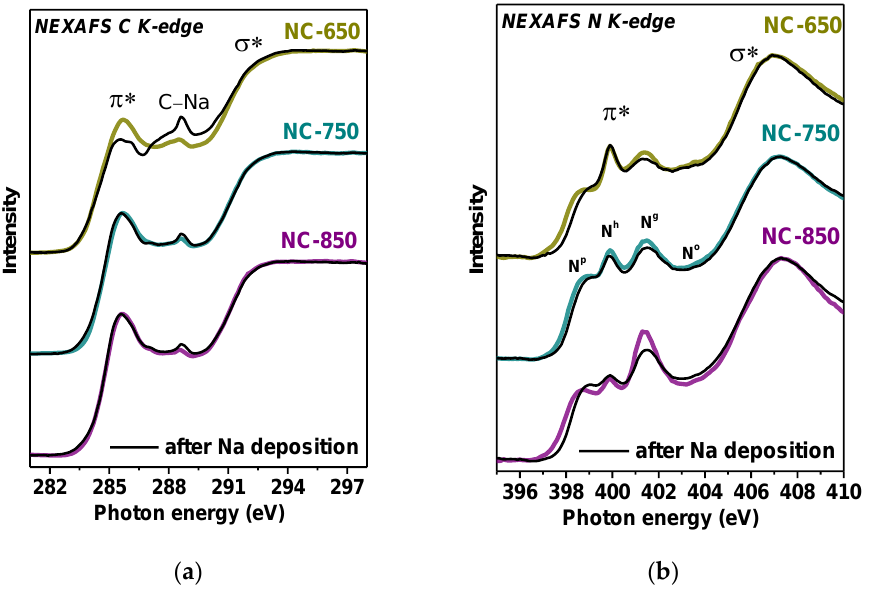
Figure 9. NEXAFS ( a ) C K-edge and ( b ) N K-edge spectra of NC-650, NC-750, and NC-850 before and after sodium deposition (black line).